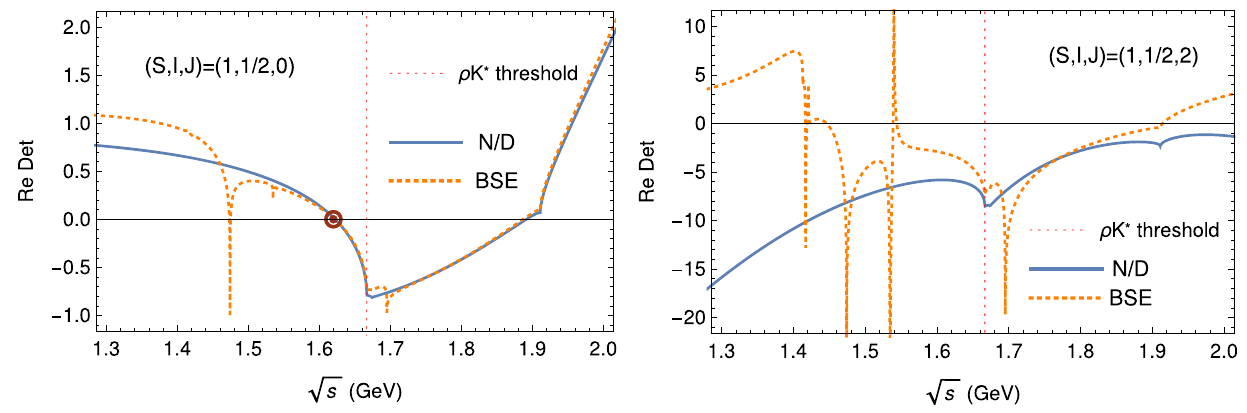
Fig. 9 Real part of the determinant of the D ( s ) matrix for the cases of ( S , I , J ) = ( 1 , 1 / 2 , 0 ) and ( 1 , 1 / 2 , 2 ) on the physical Riemann sheet evaluated with q max = 0 . 875 GeV and g = 4 . 596. A bound state is found in the scalar sector, while no bound state is found in the tensor